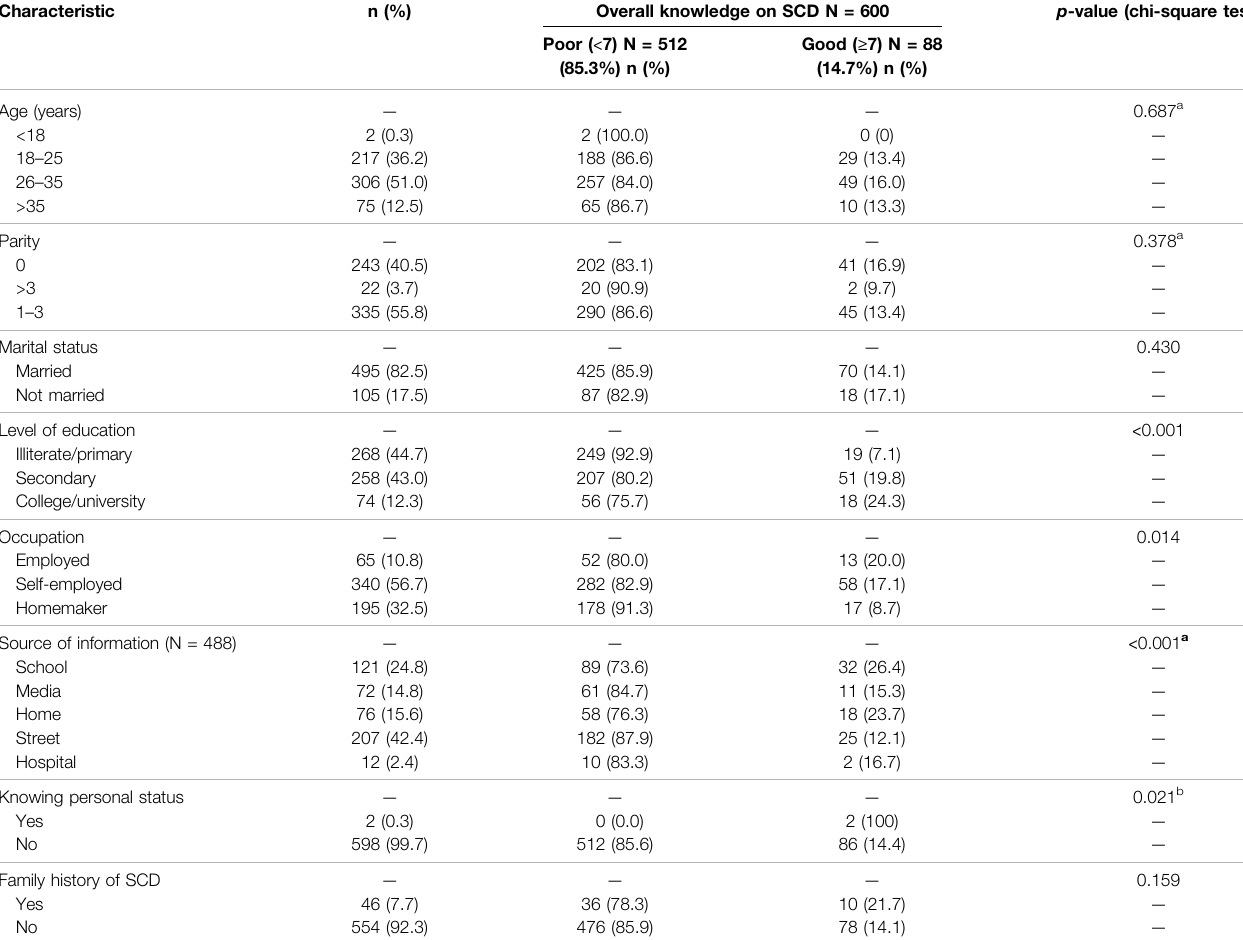
TABLE 4 | Socio-demographic characteristics and overall level of knowledge on SCD among pregnant women attending antenatal clinics in Dar-es-salaam (N = 600).